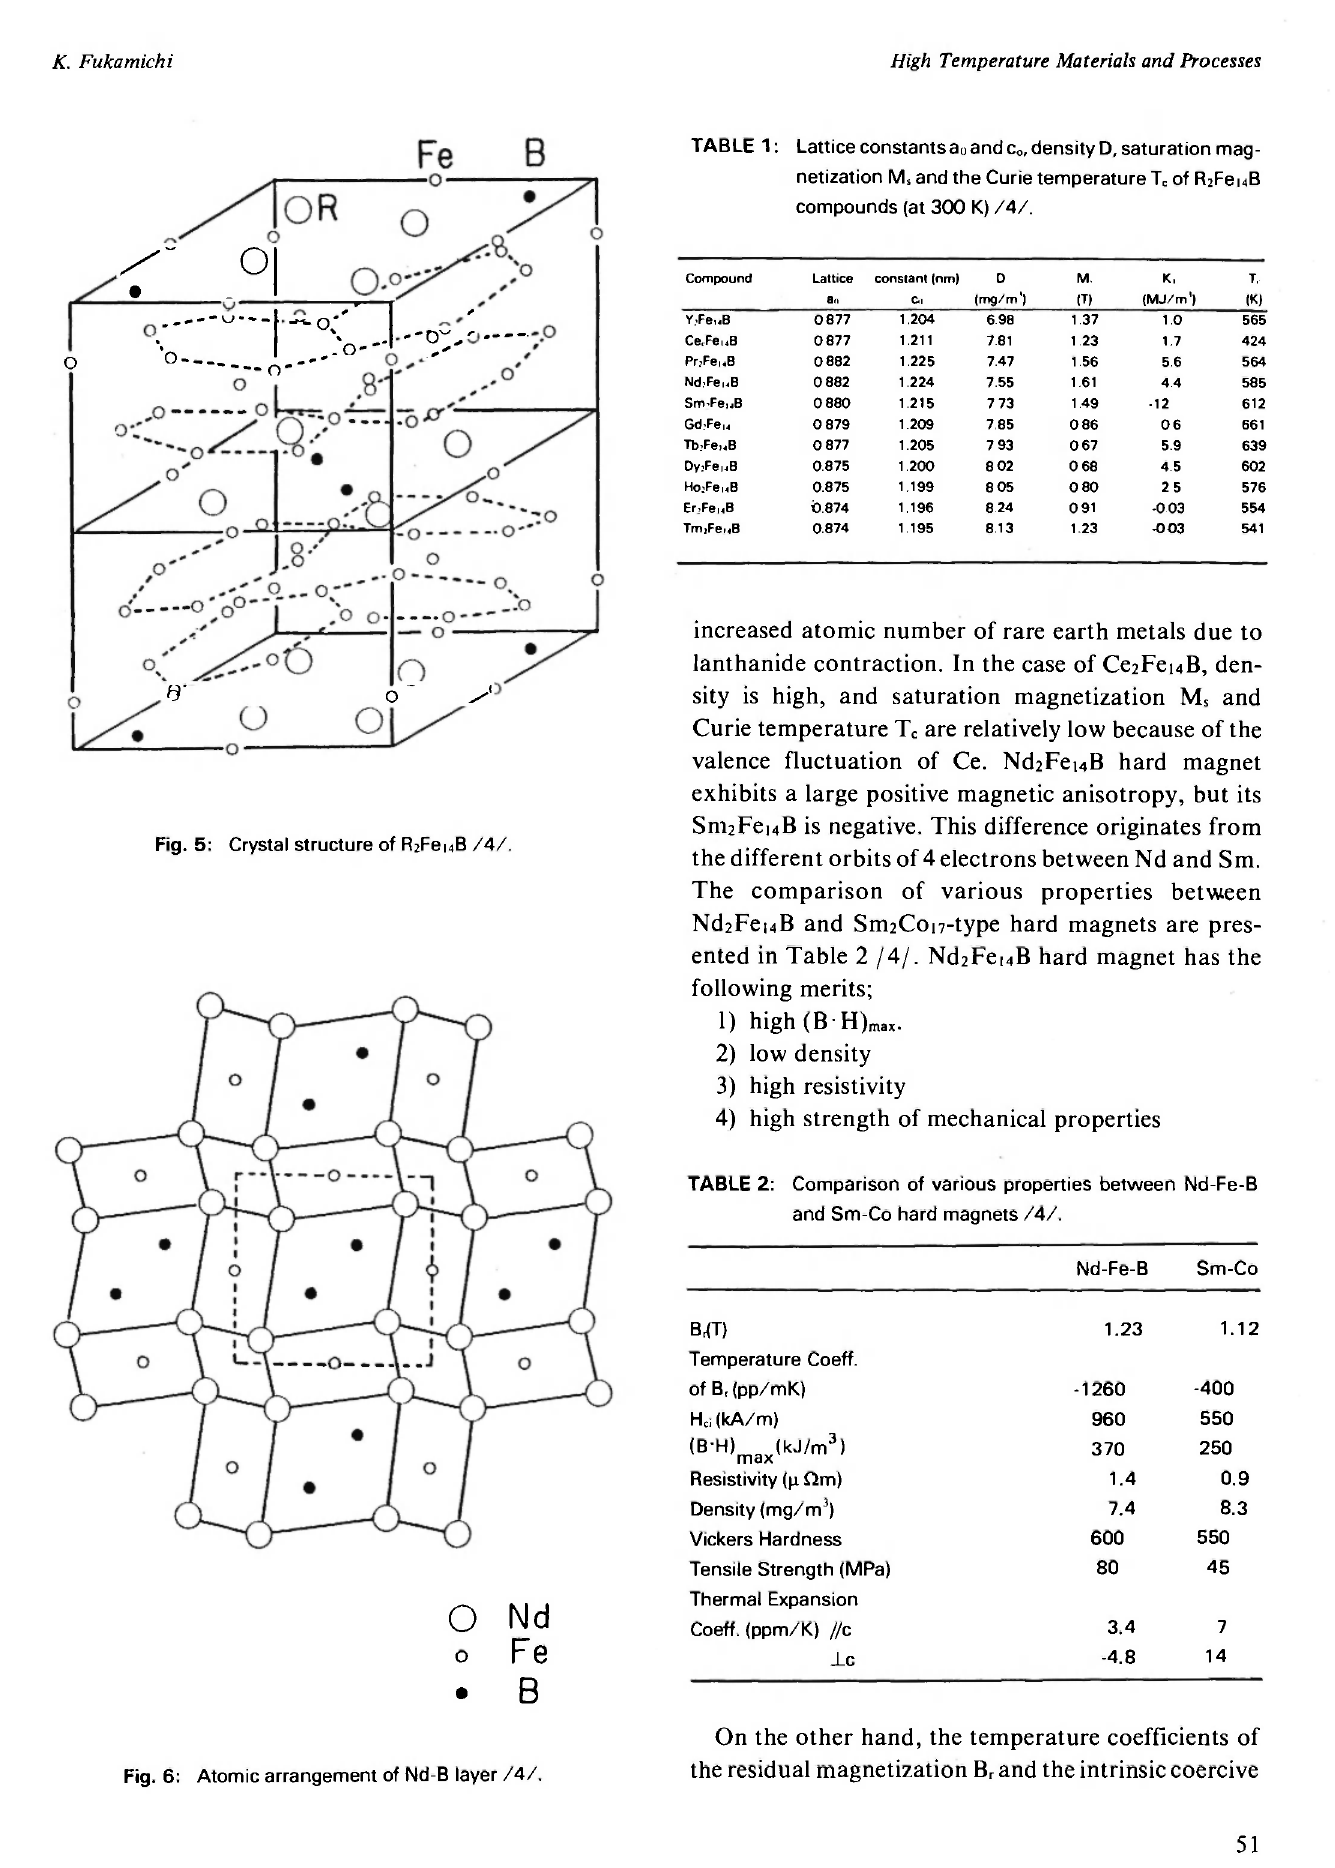
Fig. 6: Atomic arrangement of Nd-B layer /4/.